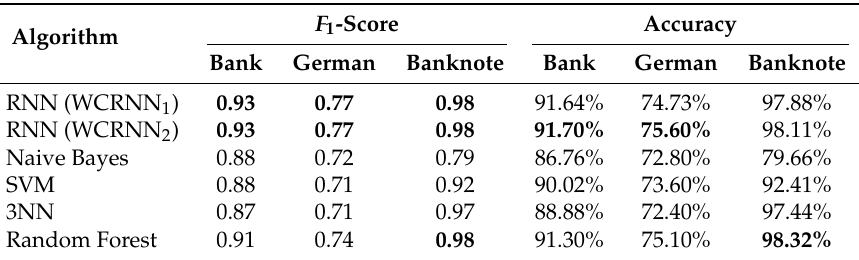
algorithms, regarding F 1 -score and